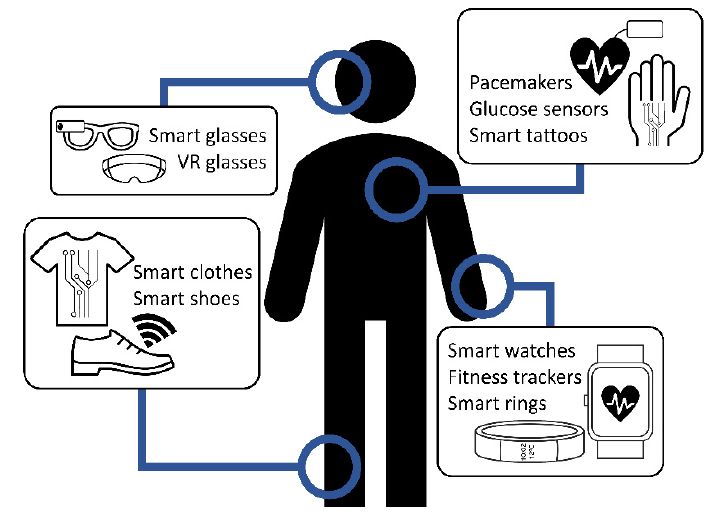
Figure 1. Examples of wearable devices.